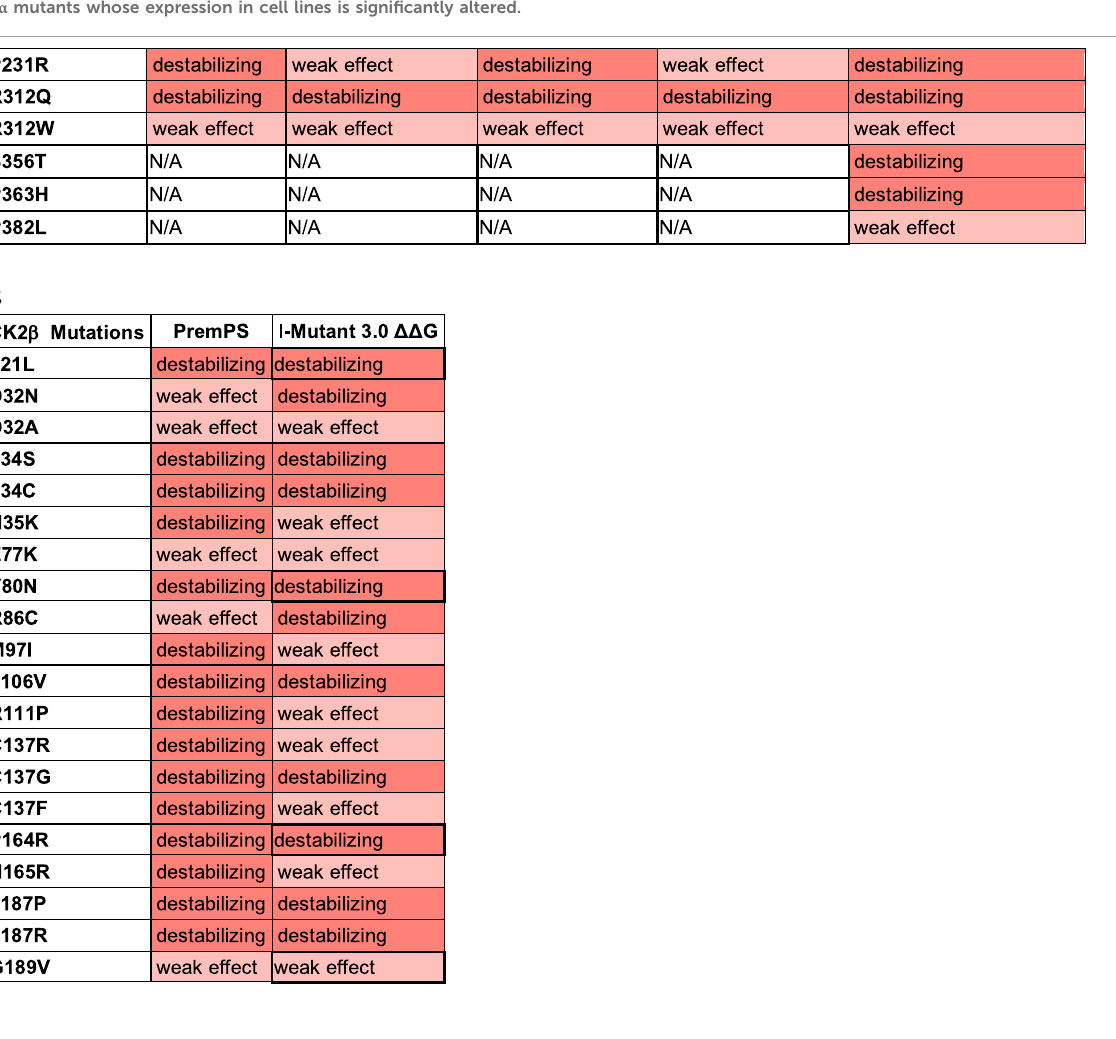
TABLE7AnalysisoftheCK2proteinmutationsusingstabilitypredictiontools.PredictionsforeachmutantinCK2 α (A)andCK2 β (B)accordingtoeach program. Highlight colors in the cells re fl ect the effect from stabilizing (white) to high destabilizing (red). The numbers obtained in the